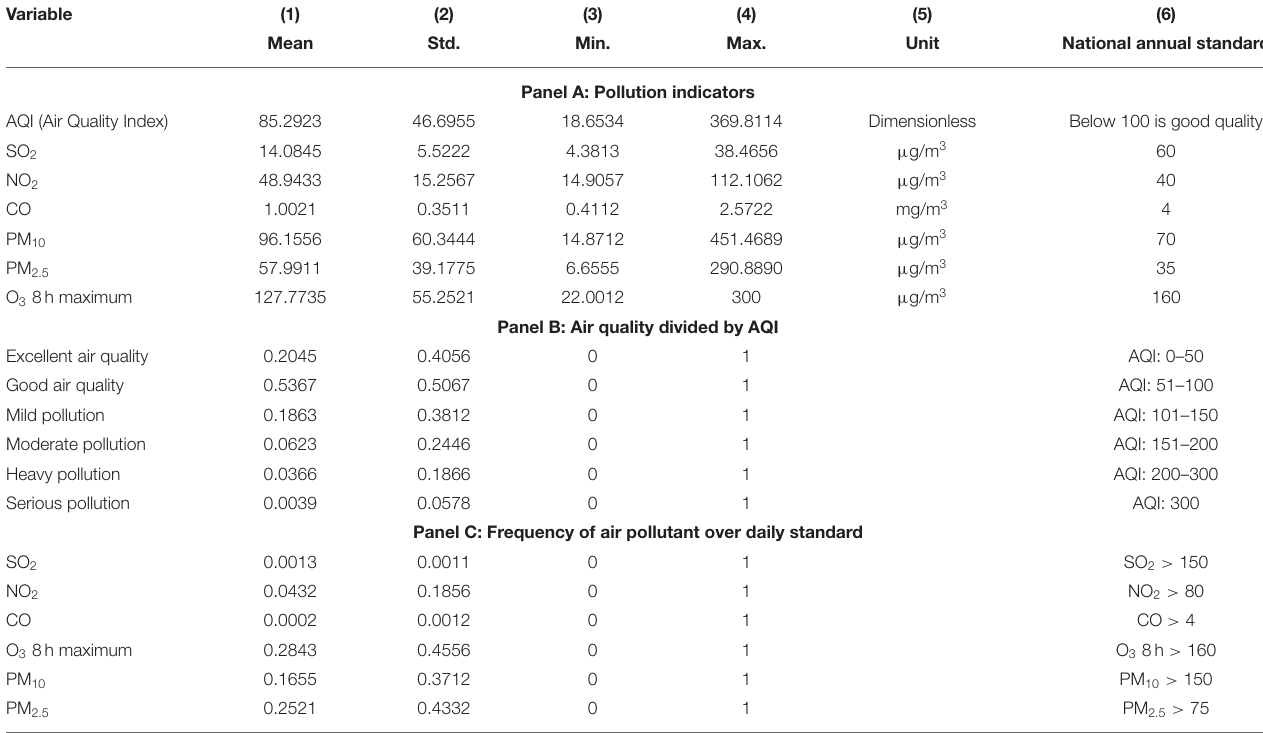
TABLE 1 | Sample city’s air pollution status.